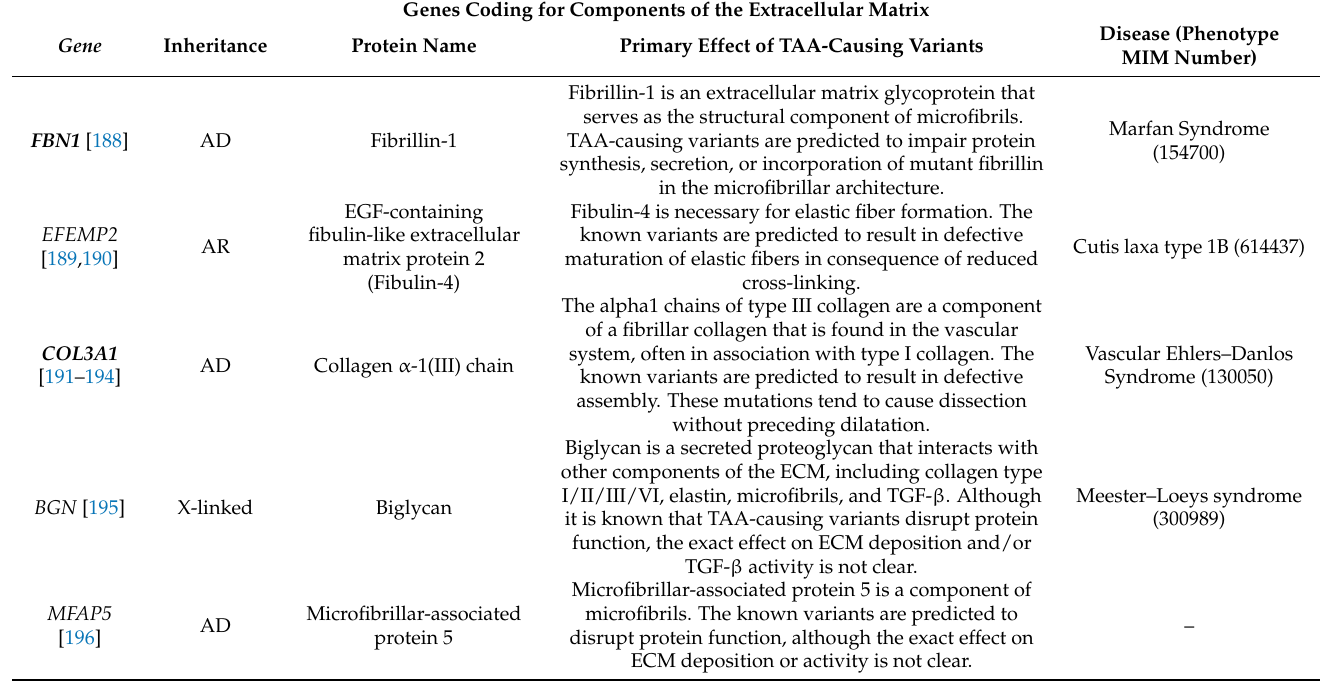
Table 1. Genes classified as “definitive” in determining predisposition to heritable thoracic aortic disease based on the Clinical Genome Resource (ClinGen) framework [5,187] are listed in